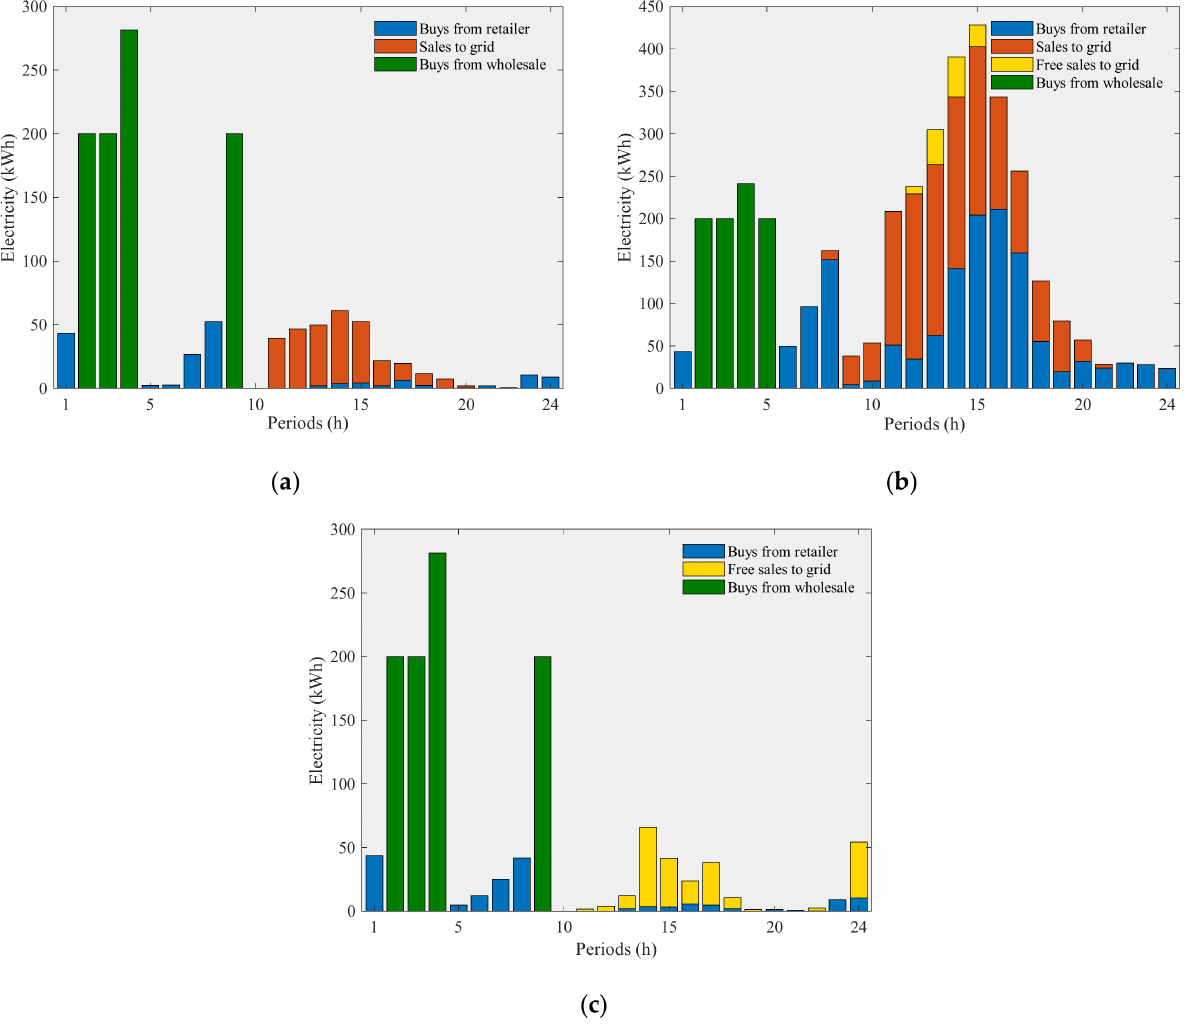
Figure 10. Electricity transactions with wholesale participation, ( a ) Scen2-CS1, ( b ) Scen-CS2, and ( c )